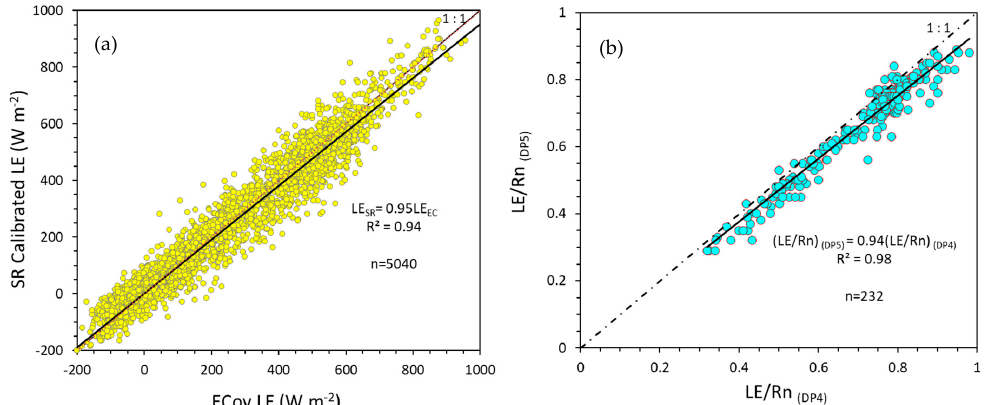
Figure 6. ( a ) Half-hourly eddy covariance (ECov) latent heat flux density (LE) versus calibrated surface renewal (SR) LE from a 104-day period at the DP3 experimental site. The LE values were computed